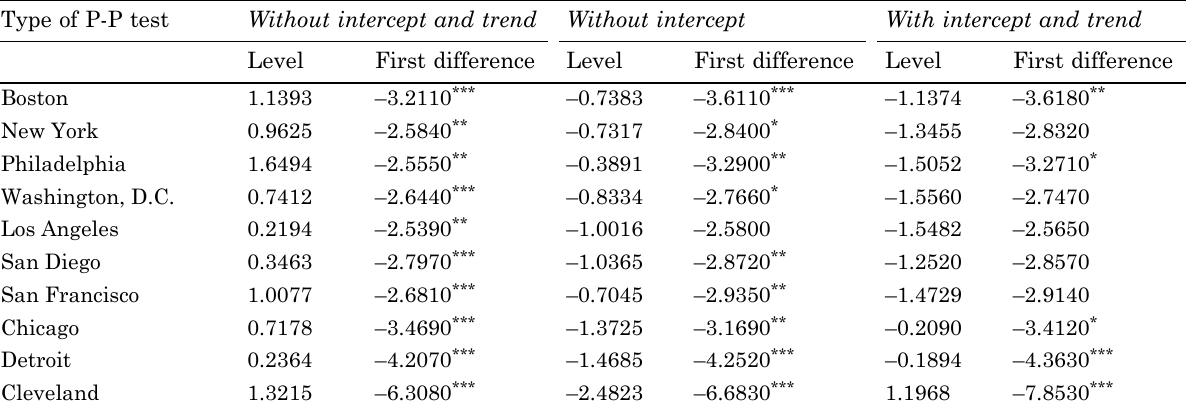
fig. 1. time trends of ten MSas’ house price indices table 2. Phillips-Perron unit root tests of ten MSas house price index type of P-P